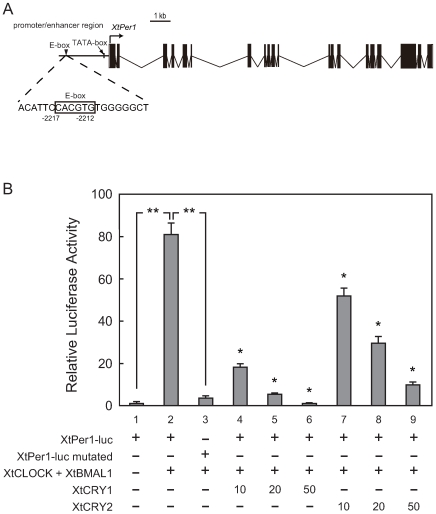
Effects of XtCRY on CLOCK:BMAL1-mediated transcriptional activation from XtPer1 E-box elements.(A) Schematic diagrams of the XtPer1 promoter region in which there is one CACGTG E-box (depicted as a closed triangle) and a TATA-box (depicted as a closed box). (B) Twenty-five nanogram of a firefly luciferase reporter with XtPer1 E-box-SV40-luc reporter, 0.5 ng of Renilla luciferase reporter, pRL-CMV as an internal control (Promega), 125 ng of XtCLOCK expression vector, 12.5 ng of XtBMAL1 expression vector, and 0, 10, 20, or 50 ng of XtCRY expression vector were mixed. The total amount of plasmids was adjusted to 1 µg per well by adding pcDNA3.2/V5-DEST empty vector. All data presented are the means ±SD for three independent experiments. **p<0.0001, Student's t-test, *p<0.05, Tukey-Kramer test, comparing the effect of 4, 5, 6 to 2; or 7, 8, 9 to 2.